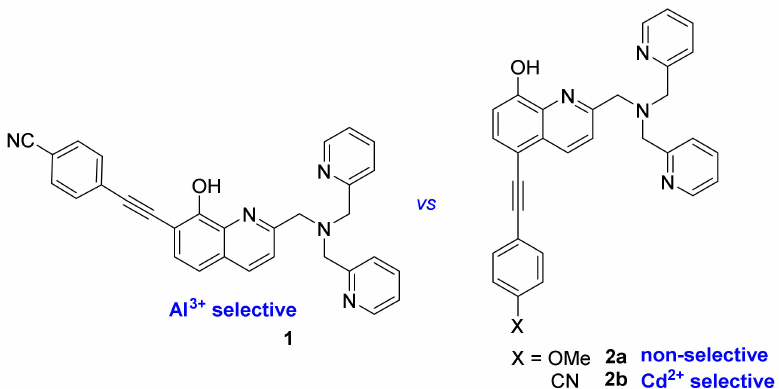
Figure 1. Electronic and regio-effects of a quinoline-based tolan for metal